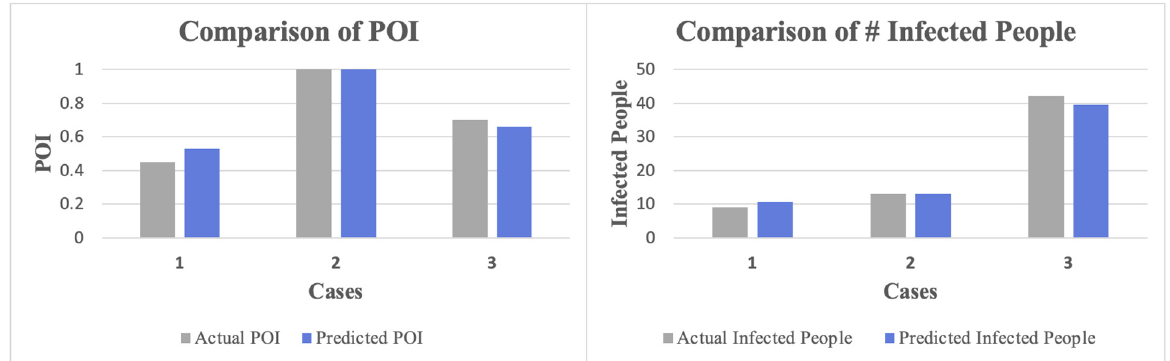
Figure 5. Comparison of Wells–Riley model predictions against actual data of reported COVID-19 cases.